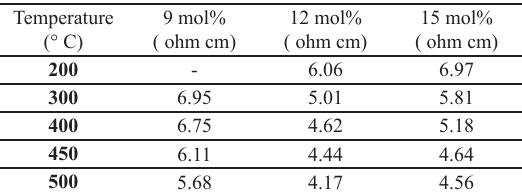
Table 6. Log Resistivity of 3 compositions vs Temperature by Two Probe Method.